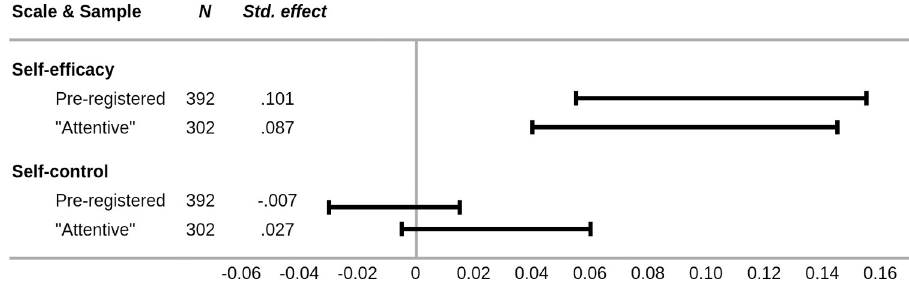
Fig 2. Standardized effect coefficients and confidence intervals for the cue-thought habit mediation effect between conscientiousness and self-efficacy/control (pre-registered and attentive subsample). Note. “Std.” =